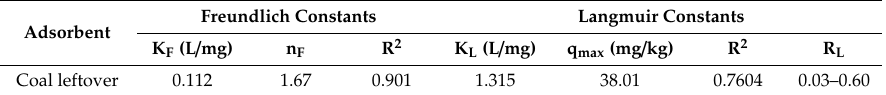
Figure 4. The plot of Langmuir and Freundlich adsorption isotherm (Temperature: 20 ◦ C; contact time 1440 min; dose 40 g / L; adsorbent size 0.075–0.425 mm). Table 2. Freundlich and Langmuir isotherm